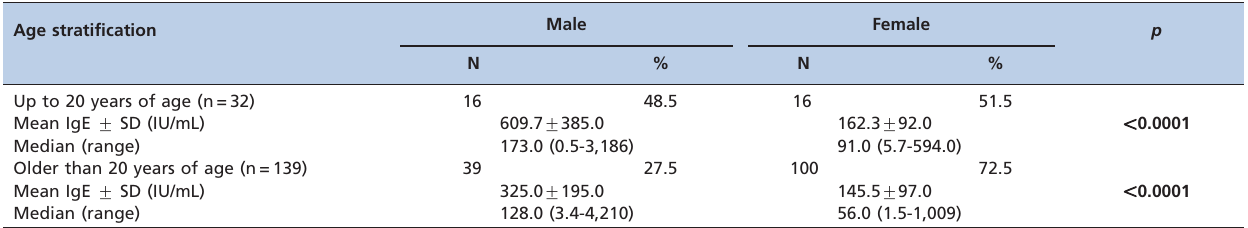
Table 2 - Mean values for total IgE plasma levels (IU/mL) of males and females aged up to or older than 20 years old. Age stratification